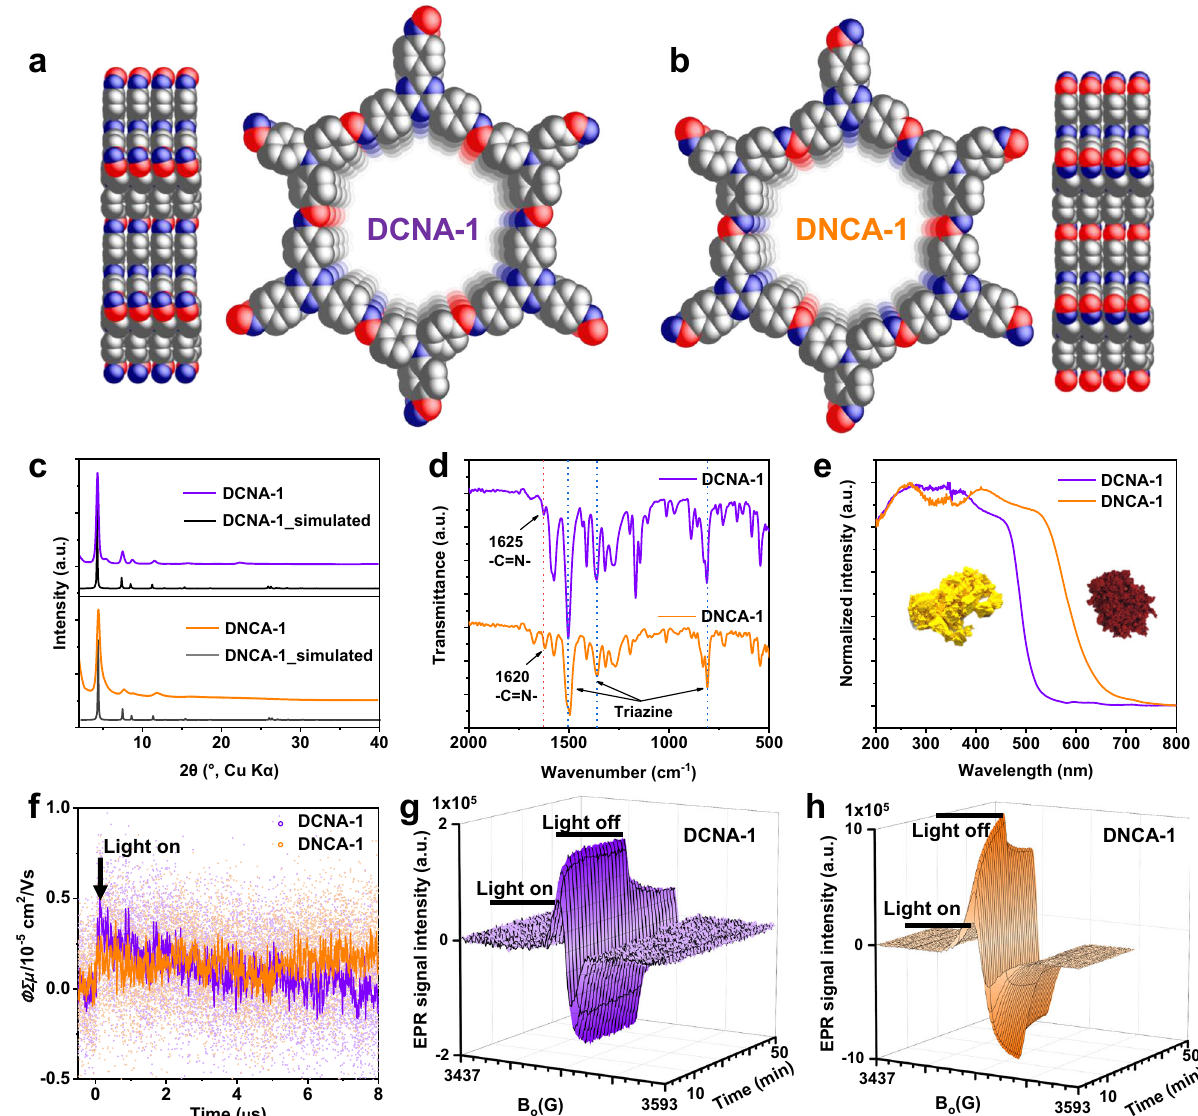
Fig. 2 | Characterization of the constitutional isomers DCNA-1 / DNCA-1. Structure models of the isomeric COFs DCNA-1 ( a ) and DNCA-1 ( b ) from the side andtopviews.(Red:imine carbon,Blue:nitrogen,Gray:phenylortriazine carbon). c Experimental and simulated PXRD patterns, ( d ) FTIR spectra, ( e ) UV-Vis DRS spectra, and ( f ) fl ash-photolysis time-resolved microwave conductivity (FP-TRMC)